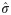
Results from Experiments 1 (2AFC_g), 2 (4AFC_g), & 3 (4AFC_l).Each show the spread value (σ) (i.e. inverse of the slope, in log10 arcsec) as a function of the disparity threshold (θ, in log10(arcsec)). A. Results from Experiment 1. B. Experiment 2; C. Experiment 3. Green dots are the individual spreads and thresholds obtained from the fitting. The red dots in panels A and B correspond to the spread and thresholds values of the participants described in Fig 3. Black lines are fitted regression lines (dashed lines: 95% regression confidence interval for the mean). A. σ^(θ)2AFC_g = 0.462+0.355×θ B. σ^(θ)4AFC_g = -0.823+1.305×θ. C. σ^(θ)4AFC_l = -0.159+0.934×θ. Top right of the panels shows the Pearson correlation between thresholds and spread (θ and σ).